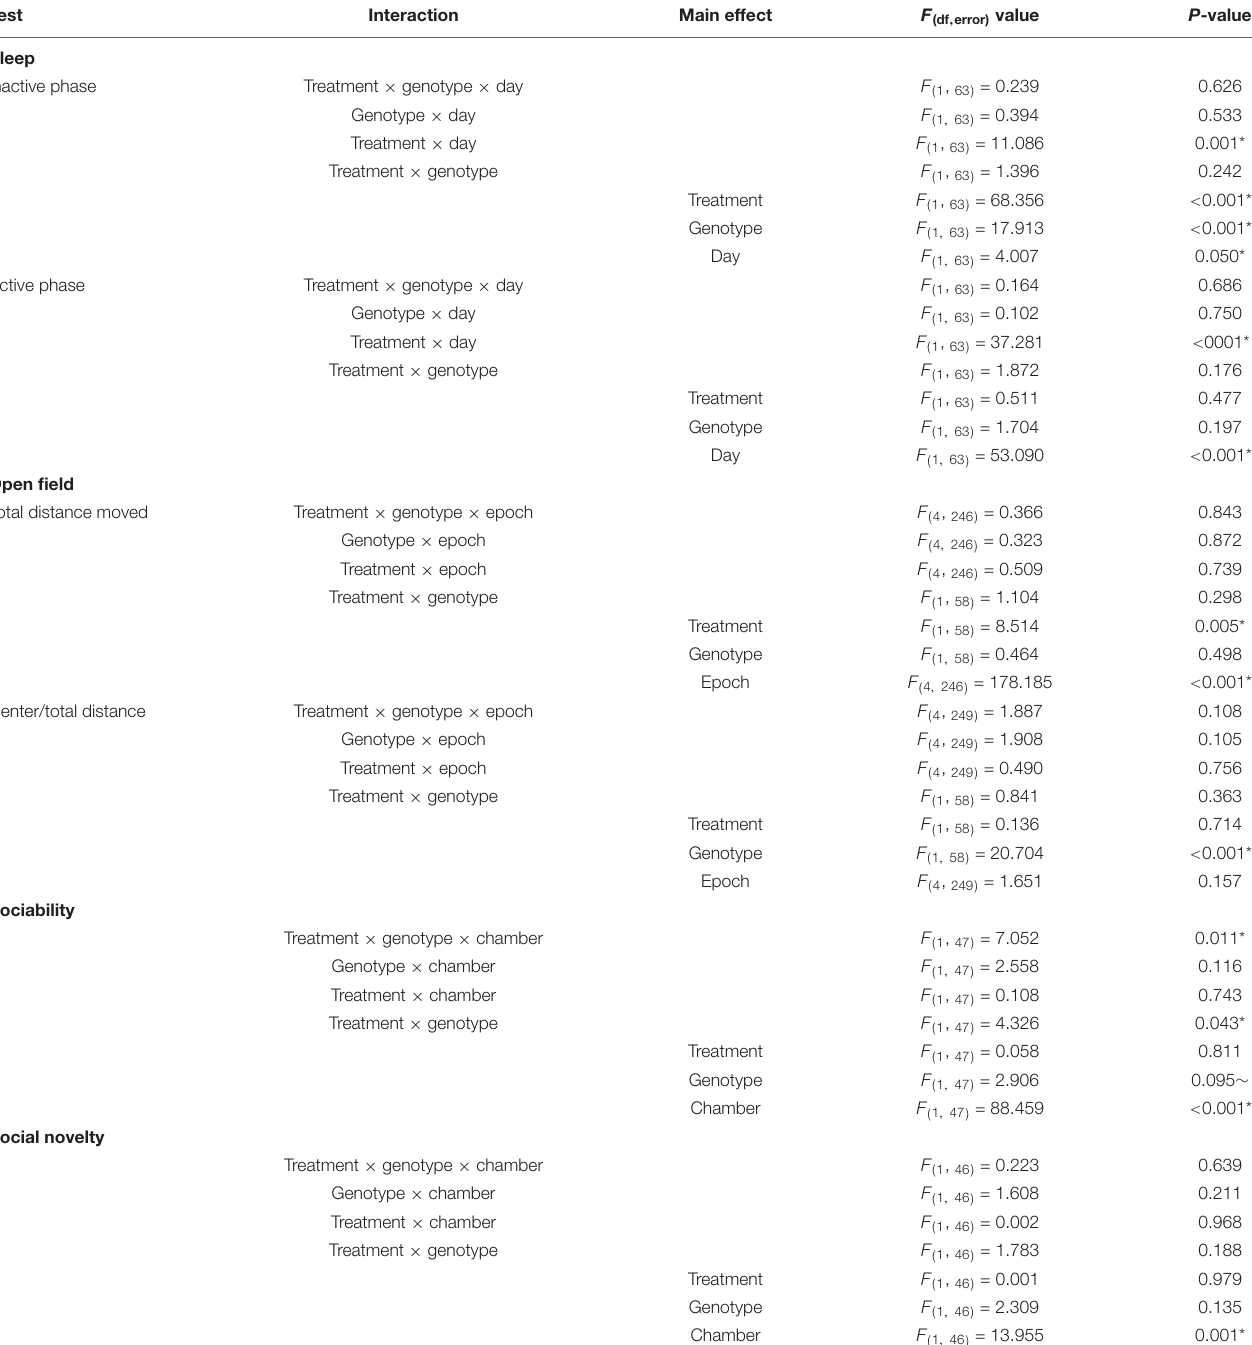
TABLE 2 | Effects of caffeine: results of mixed model